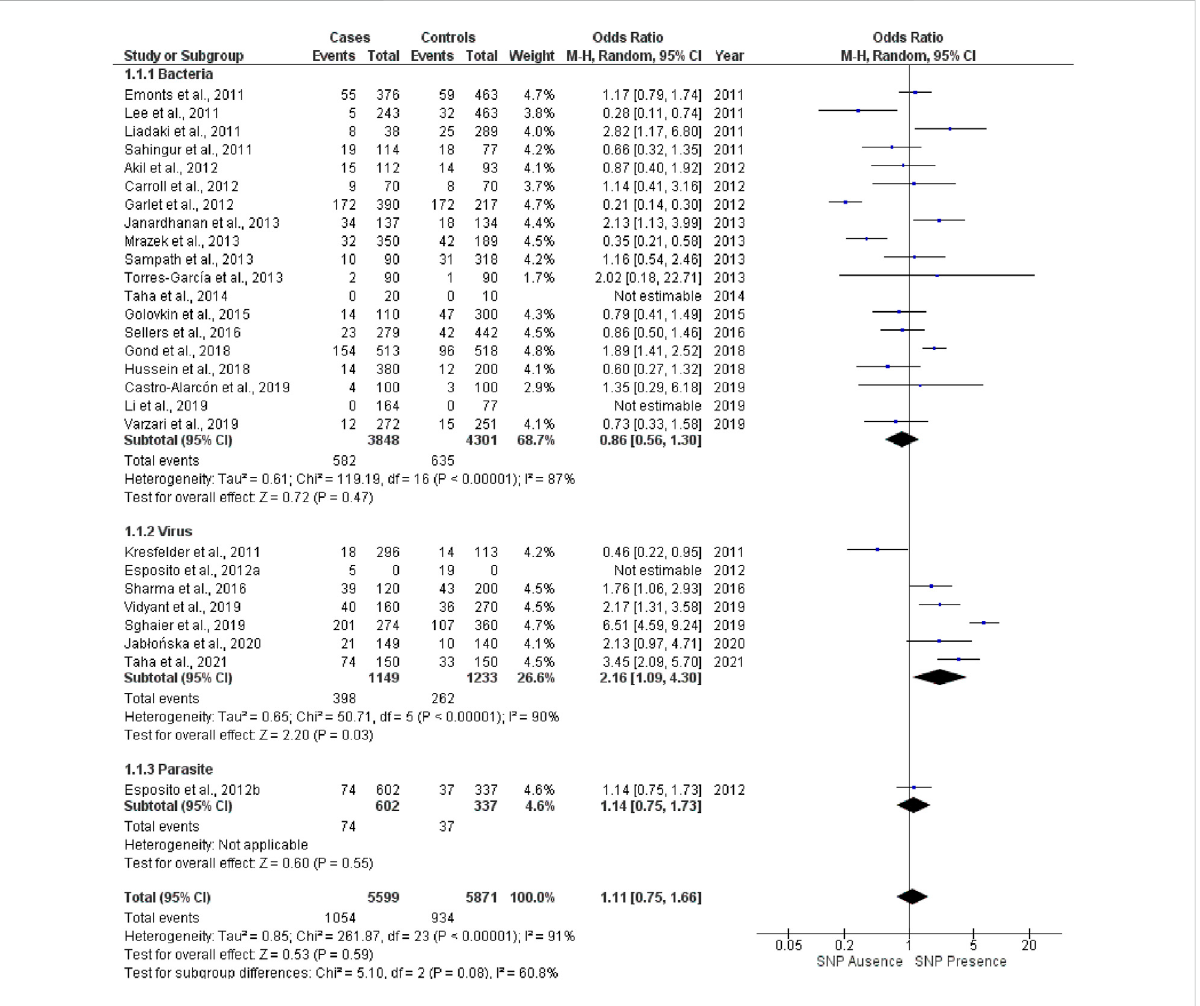
FIGURE 3 Forest plot of the association between the SNP rs4986790 of the TLR4 gene and susceptibility to infectious diseases in a dominant genotypic